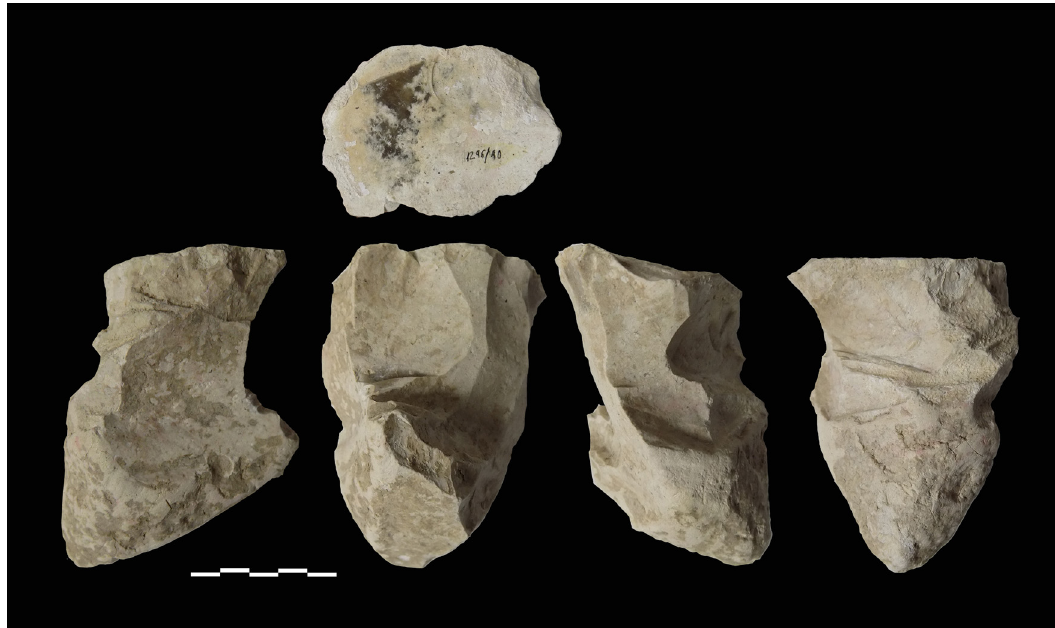
Figure 4: An opaline fl int core from an unskilled knapper with successive removals with deep hinge terminations. Number: 1296/10. Photograph: N. Castañeda.